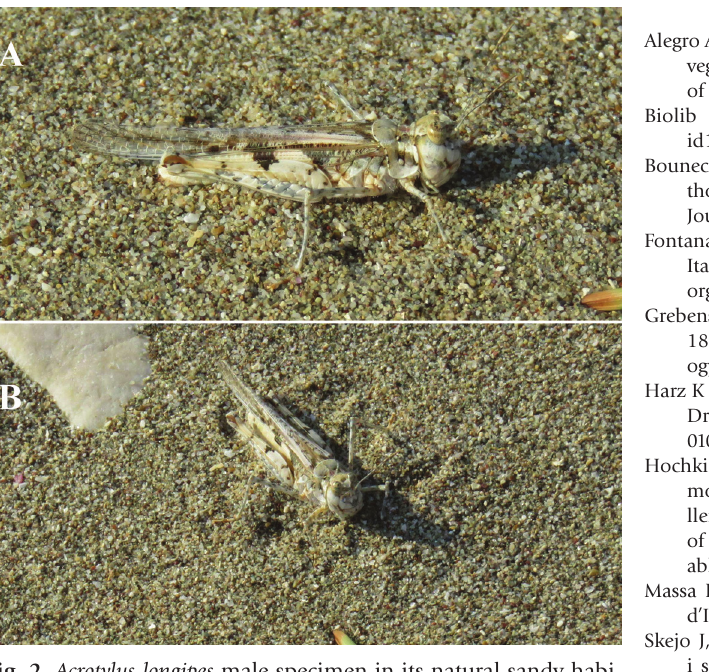
Fig. 2. Acrotylus longipes male specimen in its natural sandy habi- tat. A. Lateral view; B. Dorsal view. were observed of both males and females. Because of its fine, cryptic coloration as an adaptation to the structure of the sand, it is barely visible on the sand surface, especially for potential predators. The insect is mostly visible when jumping. The yellow- winged digging grasshopper is distinguishable from other